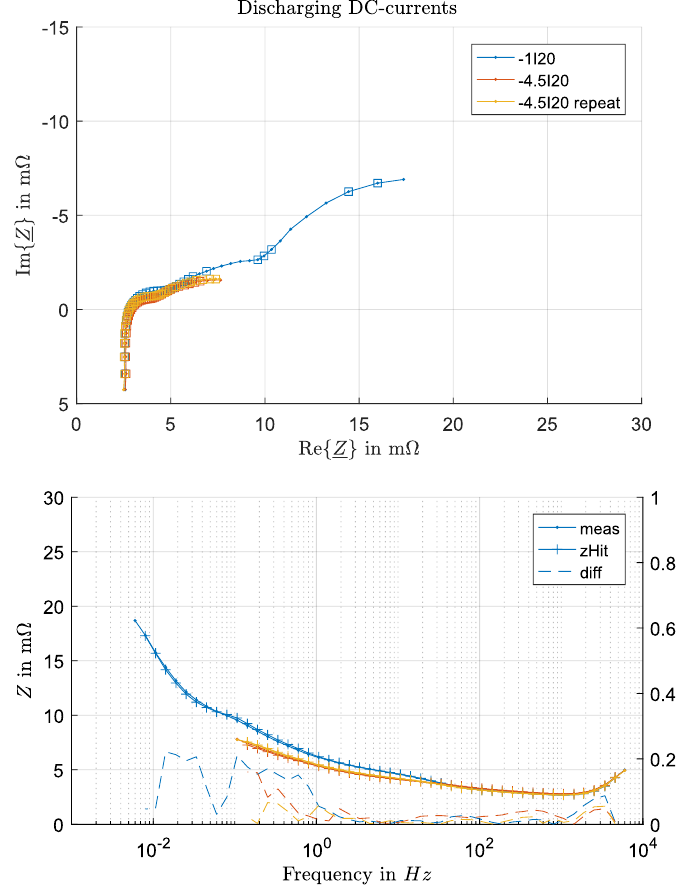
Figure 5. Impedance spectra measured on TC 1 of hard AK3.4 at the end of the first cycling phase (after 15FCE). Impedance spectra with discharging DC-currents are presented as a Nyquist diagram at the top. The impedance values, which pass the LTI criterion, are marked with squares. The impedance amplitudes measured and calculated with the zHit method are shown over the frequency at the bottom. The absolute difference between the amplitudes is presented as well with its own y -axis on the right